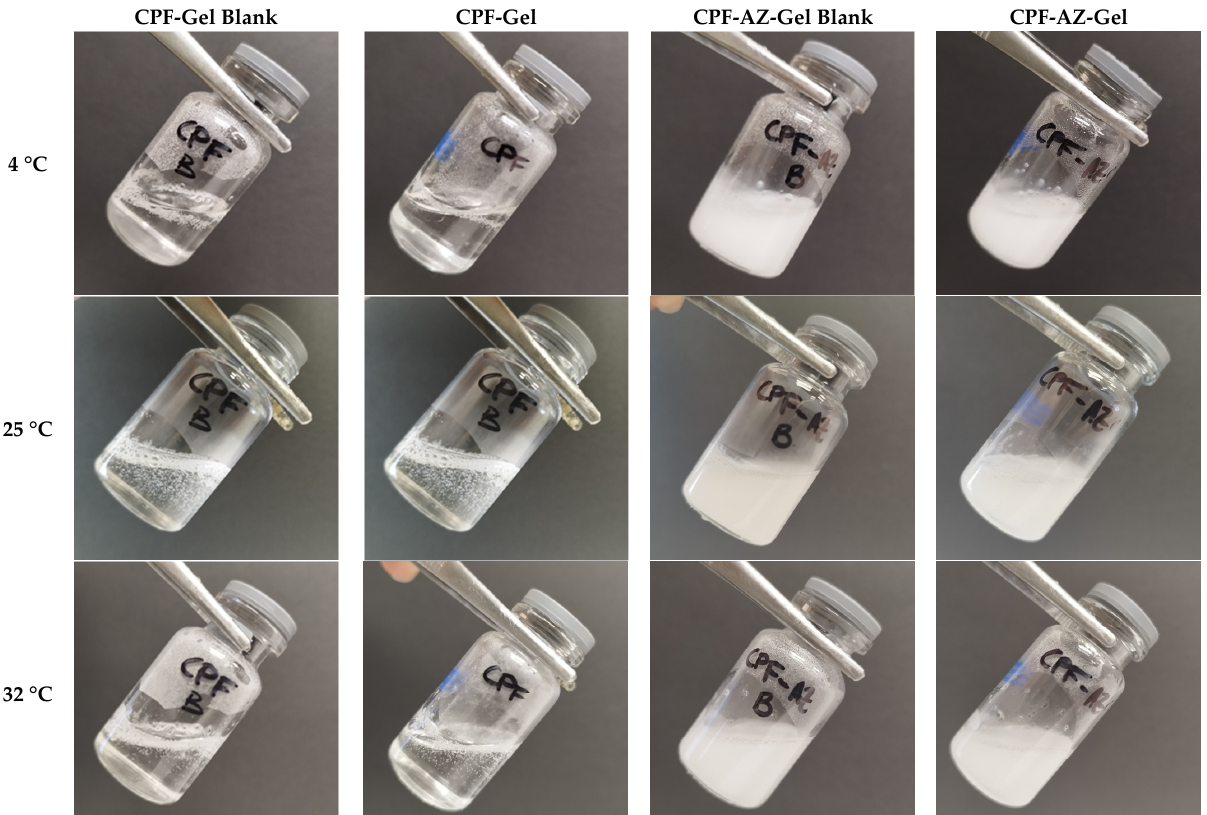
Figure 5. Physical appearance of the hydrogels at di ff erent temperatures: 4 °C, 25 °C, and 32 °C.